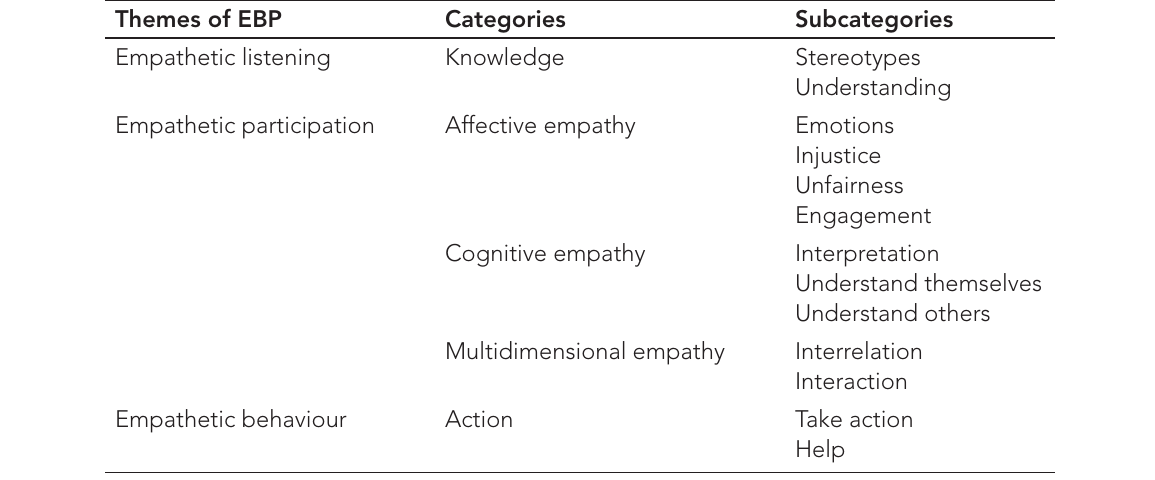
Table 1. Coding scheme used to analyse the collected data (Source: Author,